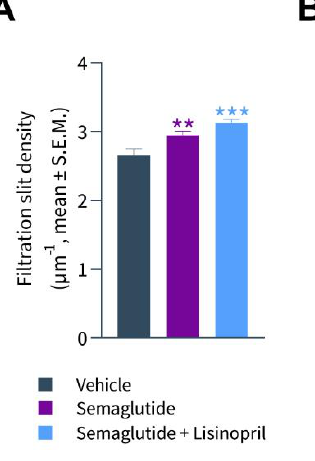
Figure 6. Semaglutide improves podocyte foot process ultrastructure in db / db UNx-ReninAAV mice. ( A ) Semaglutide monotherapy (30 nmol/kg, s.c., q.d. n = 15) and combined lisinopril treatment (30 mg/kg, p.o., n = 14) reduces severity of podocyte foot process effacement in db / db UNx-ReninAAV mice, as indicated by increased filtration slit density (FSD). Vehicle-dosed (s.c, q.d.) db / db UNx- ReninAAV mice ( n = 15) served as controls. ** p < 0.01, *** p < 0.001 vs. vehicle-dosed db / db UNx-ReninAAV mice (one-way ANOVA). The FSD of 20 glomeruli was determined for every animal. ( B ) Upper panels: Photomicrographs of podocin-stained glomeruli obtained by wide field microscopy and after SIM reconstruction. The 3D-SIM (z-stack) images of slit diaphragms were colorized according to their position on the z -axis ( µ m). Lower panels: As shown by increased magnification, the space between podocin-stained capillary loops was increased in vehicle-dosed db / db UNx- ReninAAV mice, indicative of aberrant foot process architecture with reduced FSD. Compared to vehicle controls, semaglutide and semaglutide + lisinopril significantly increased FSD, hence improving podocyte health in db / db UNx-ReninAAV mice. Scale bars, 5 µm.